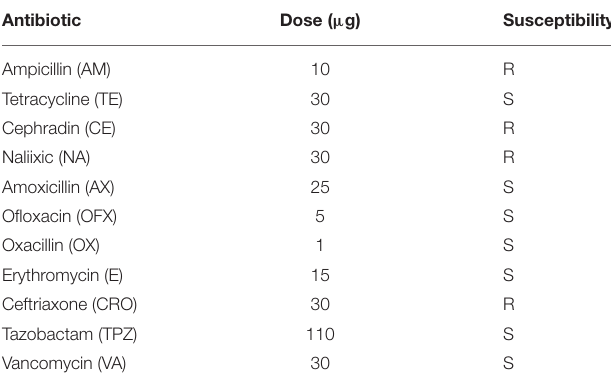
TABLE 3 | Antibiotic susceptibility of L. plantarum EI6. Antibiotic Dose ( µ